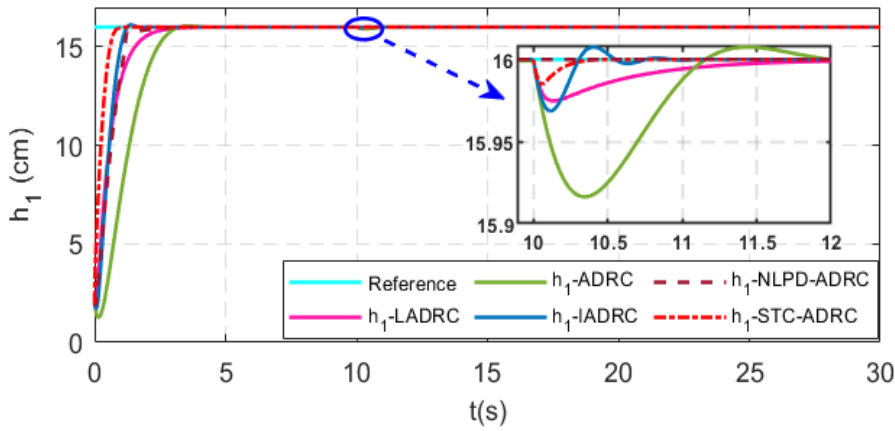
Figure 8. The water level in tank 1 with uncertainty in the outlet hole a 1 . Using the 2nd MADRC scheme.